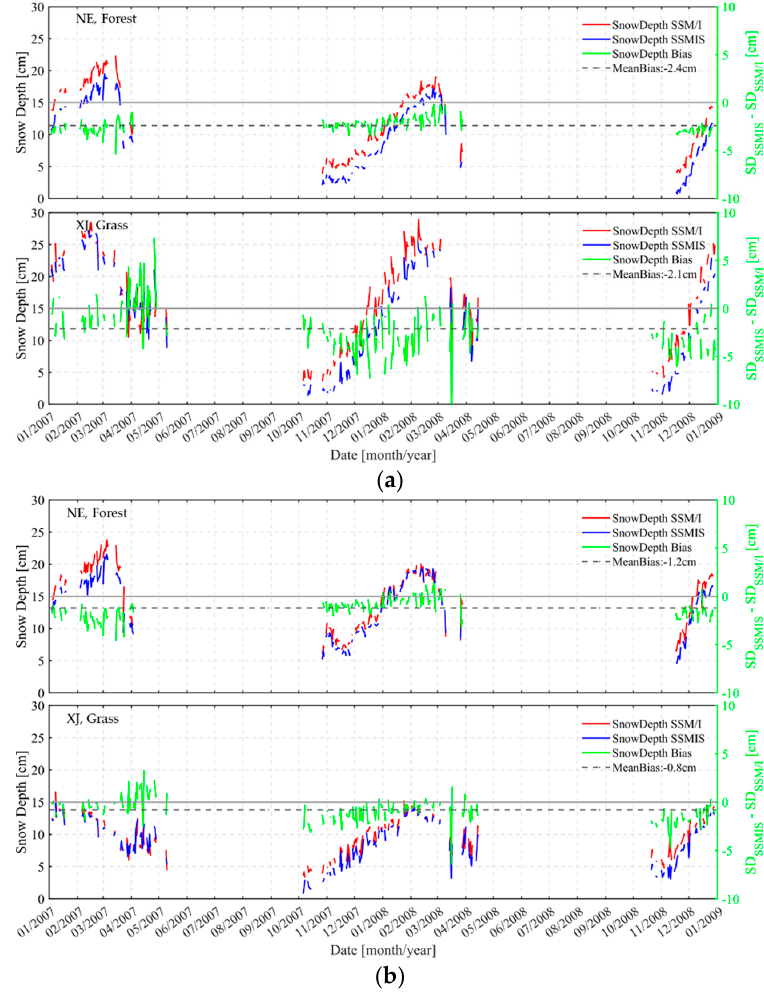
Figure 11. Time series of snow depth comparison between SSM/I and SSMIS for ( a ) dual-channel algorithm; ( b ) multichannel algorithm. Red and blue lines represent snow depth; green lines denote biases between SSMIS and SSM/I, marked as (SD SSMIS − SD SSM/I ).